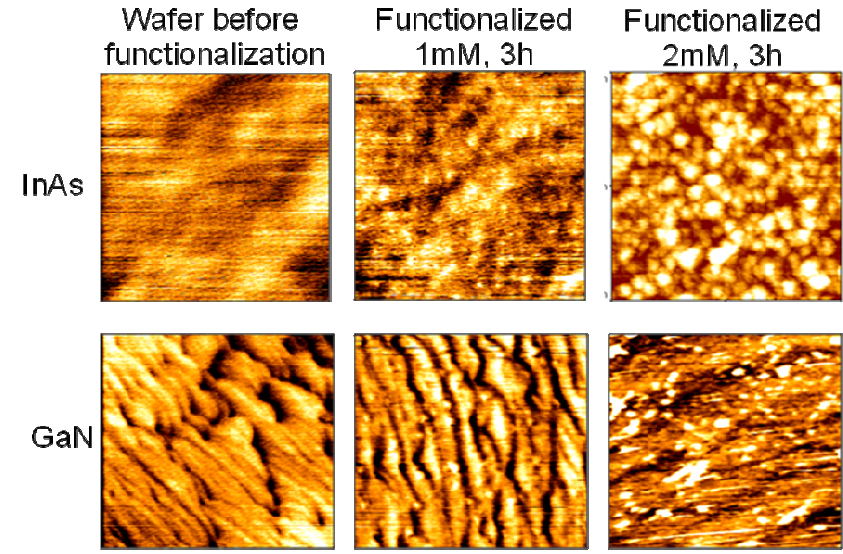
Figure 9. 500 nm × 500 nm AFM images of InAs and GaN surfaces before and after functionalizeation with 1 and 2 mM hemin solutions. White dots for 2mM solution indicate hemin aggregates